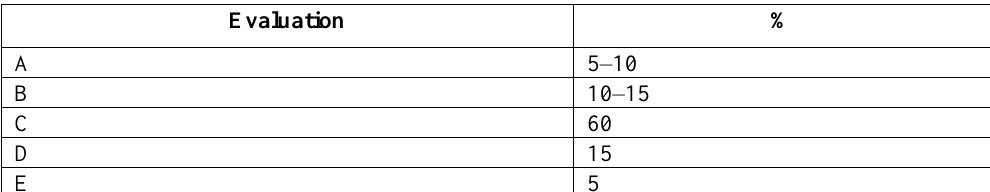
Table 1. Forced Distribution (Source: Dechev, 2010, p.